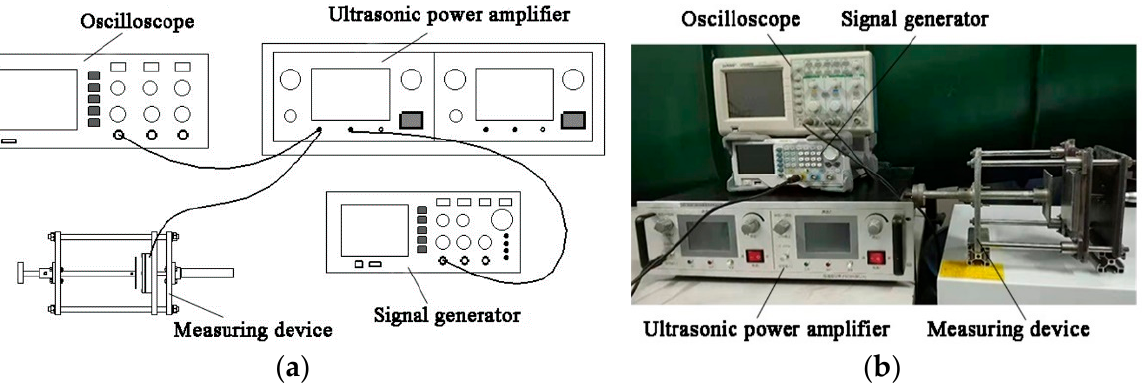
Figure 12. Experimental system: ( a ) sketch map of the experimental system; ( b ) image of the experimental system.